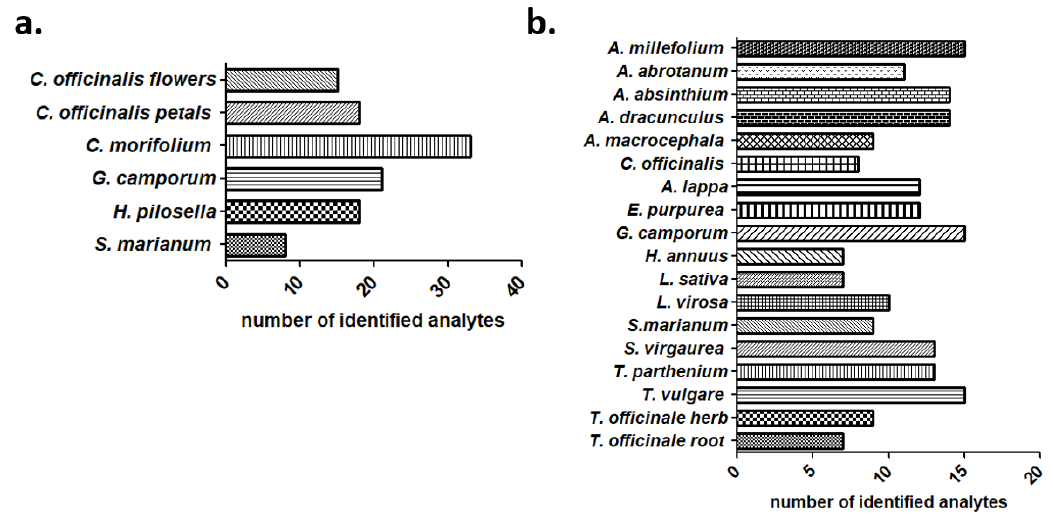
Figure 5. Number of identified phytochemicals per extract ( a ) for aqueous and ( b ) for DCM extracts. The attained results were acquired through the described suspect screening